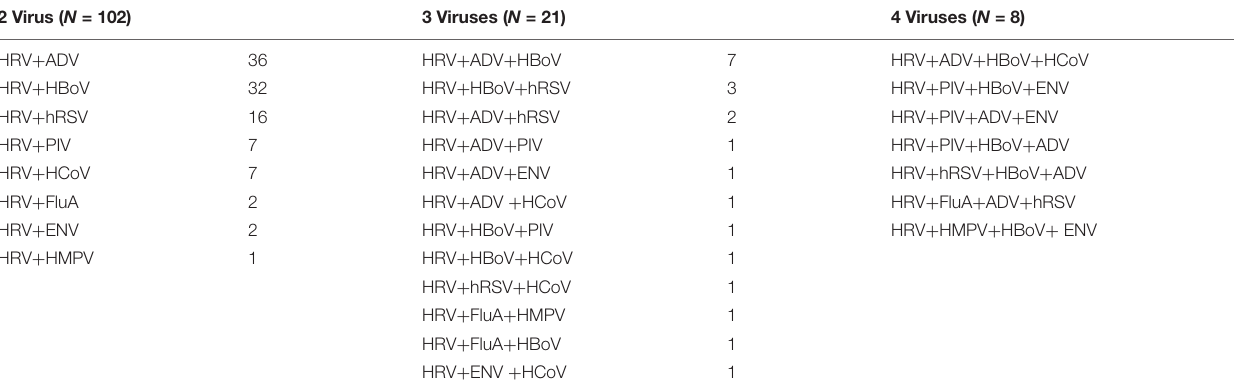
TABLE 3 | Co-detections of HRV and other respiratory virus in the study. 2 Virus ( N = 102) 3 Viruses ( N =